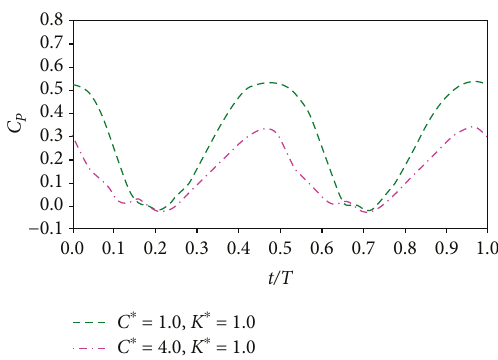
Figure 10: The time variation of power coe ffi cient of the considered cases with K ∗ = 1 0 , C ∗ = 1 0 and